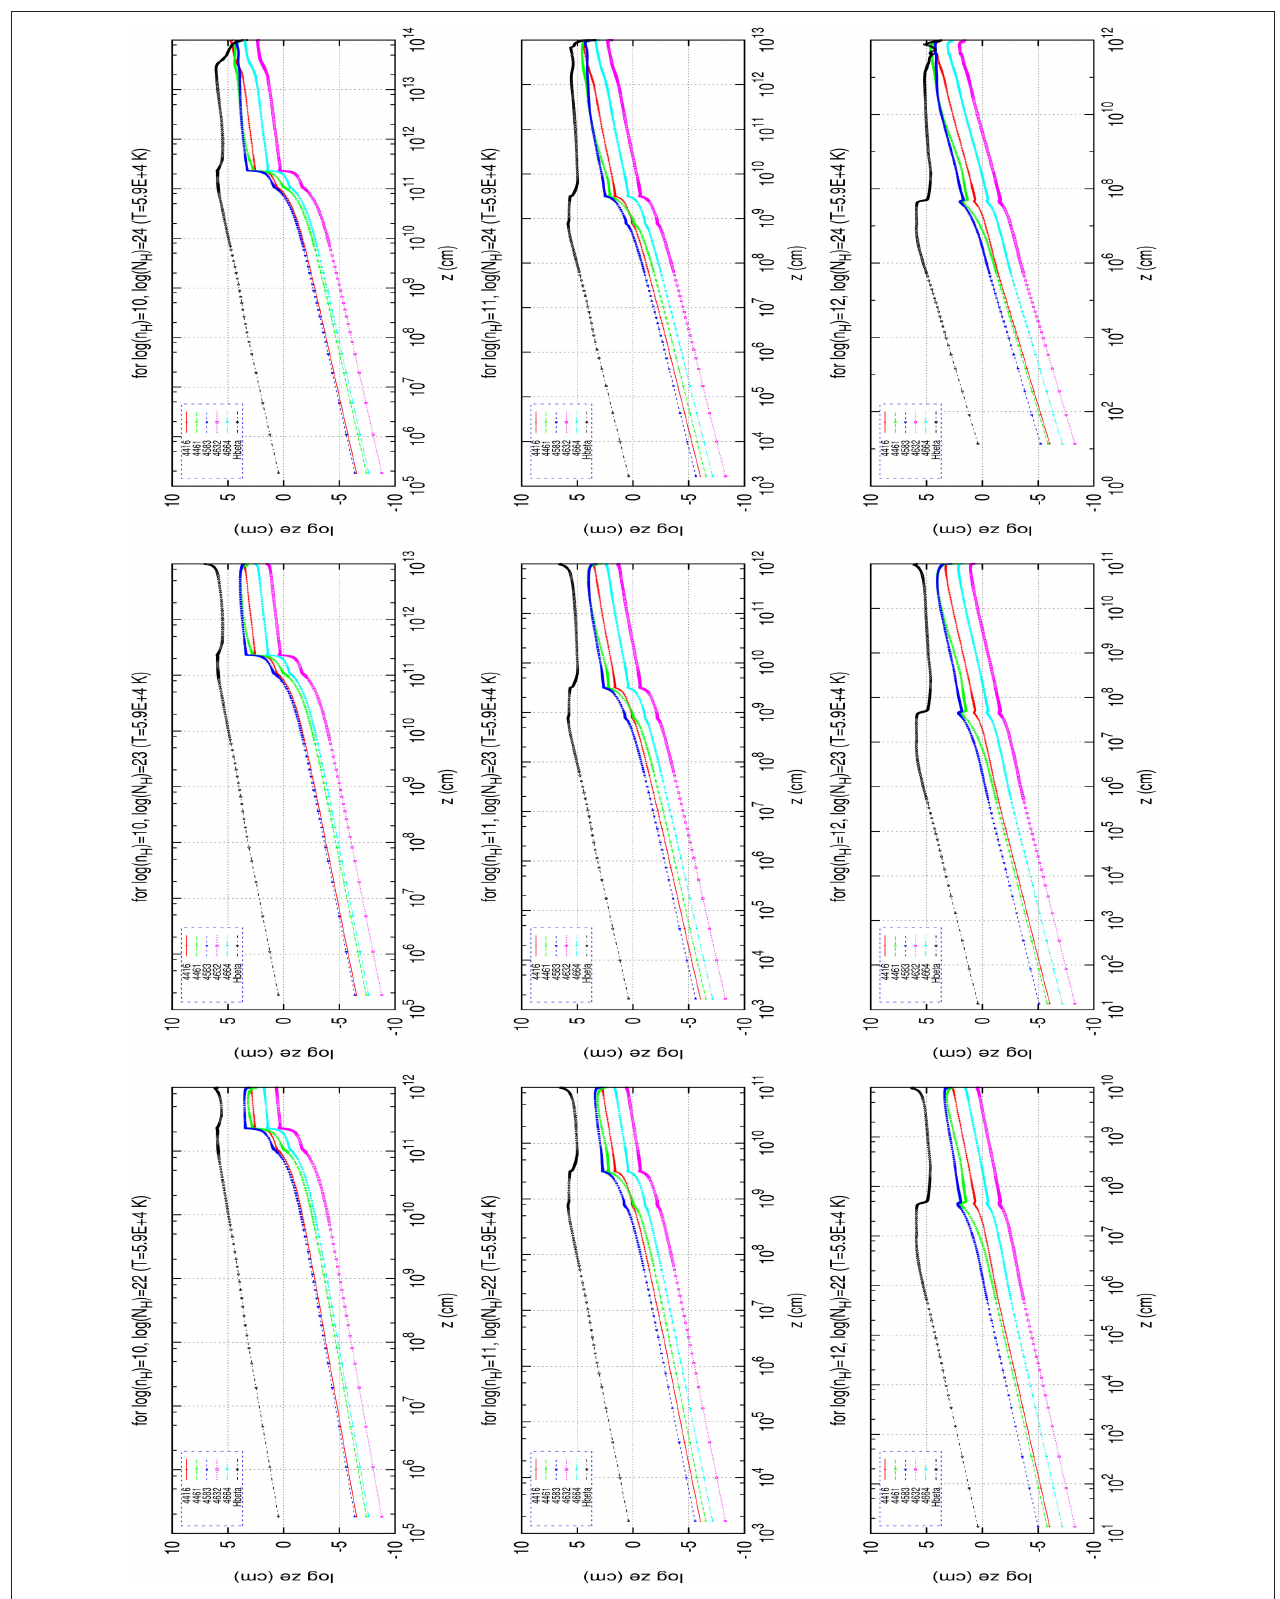
FIGURE 3 | Emissivity profiles of H β and FeII for different local densities and column densities: T BBB = 5.9 × 10 4 K. X-axis label, geometrical depth (in cm); Y-axis label, geometrical depth (z) × emissivity (e).